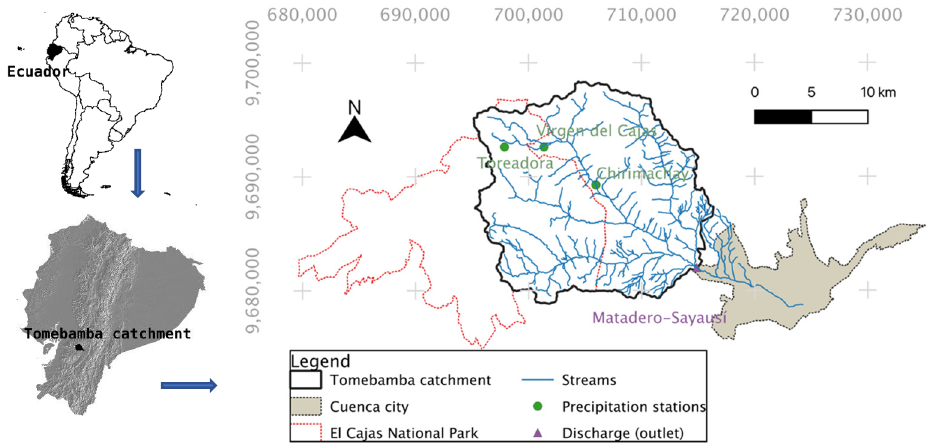
Figure 1. The Tomebamba catchment located at the Tropical Andean Cordillera of Ecuador, South America (UTM coordinates).